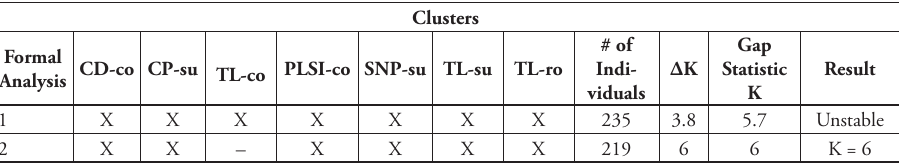
Table 2. Summary S2X only analyses one and two. ‘X’ indicates inclusion in the analysis using both AWClust and